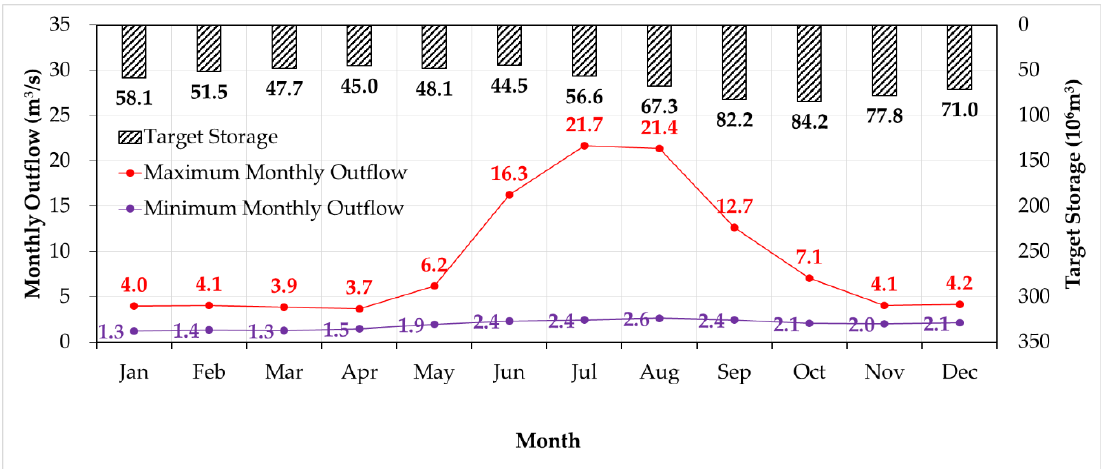
Figure 4. Monthly dam outflows for future target releases.